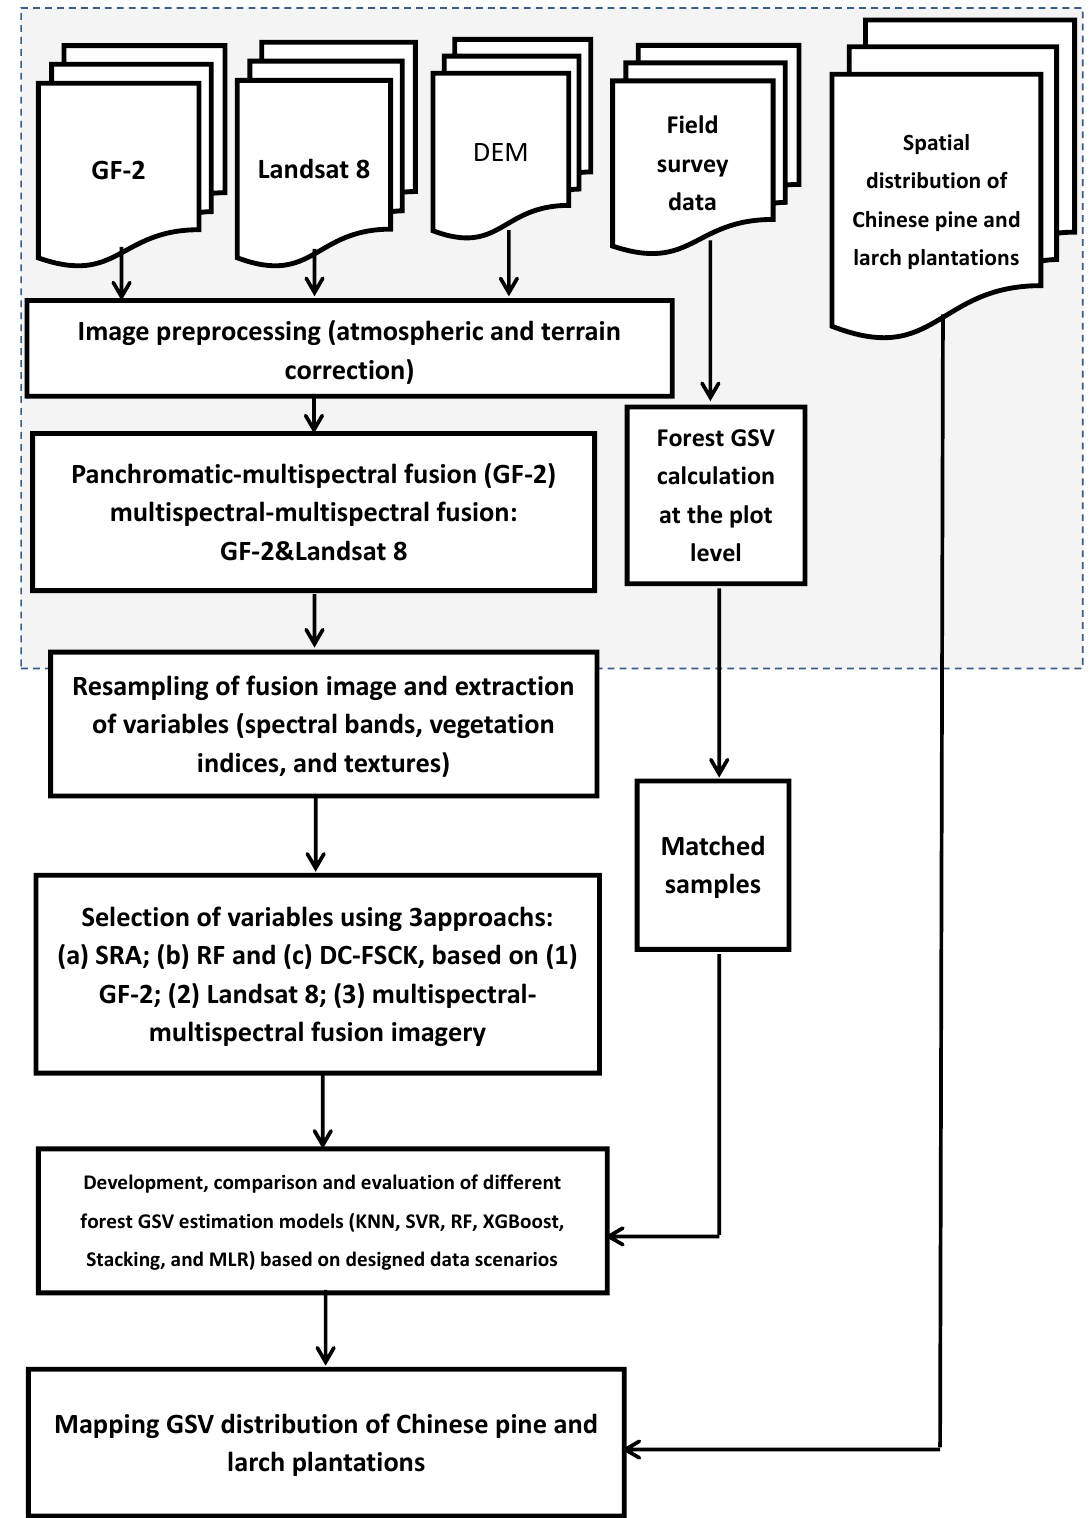
Figure 2. Methodological framework of forest GSV estimation for Chinese pine and larch plantations.